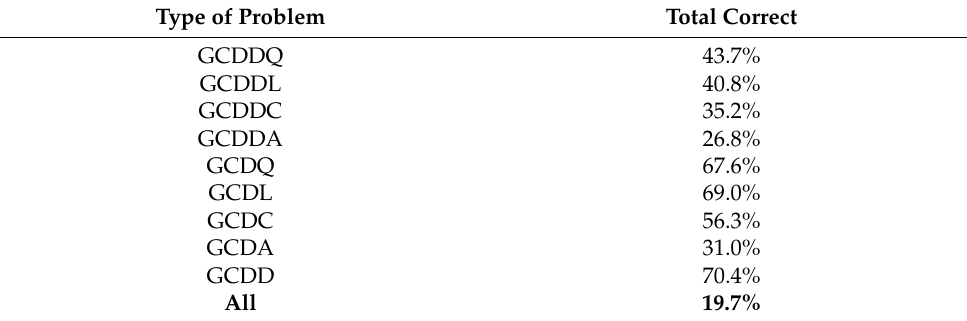
Table 2. Percentage of correct resolutions for each